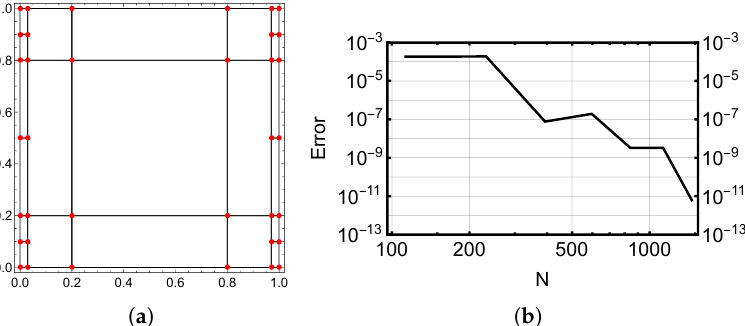
Figure 8. Reaction–diffusion with (cid:101) = 1/100. Convergence graph has a characteristic staircasing behaviour, where the even nature of the exact solution over the domain results in no convergence as the polynomial order changes from even to odd, p = 2, . . . ,8. ( a ) Symmetric mesh. ( b ) L 2 -convergence (absolute error).